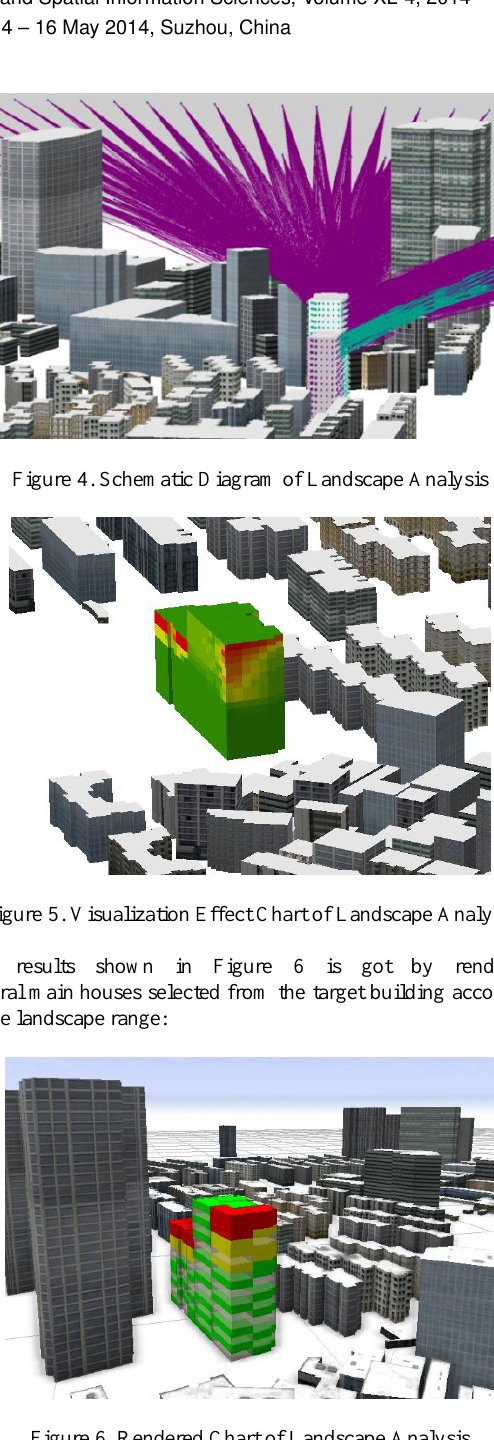
Figure 6. Rendered Chart of Landscape